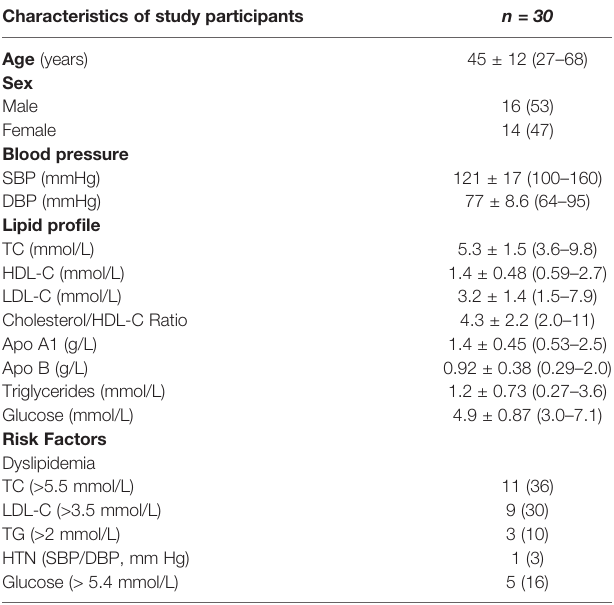
TABLE 1 | Characteristics of study participants.